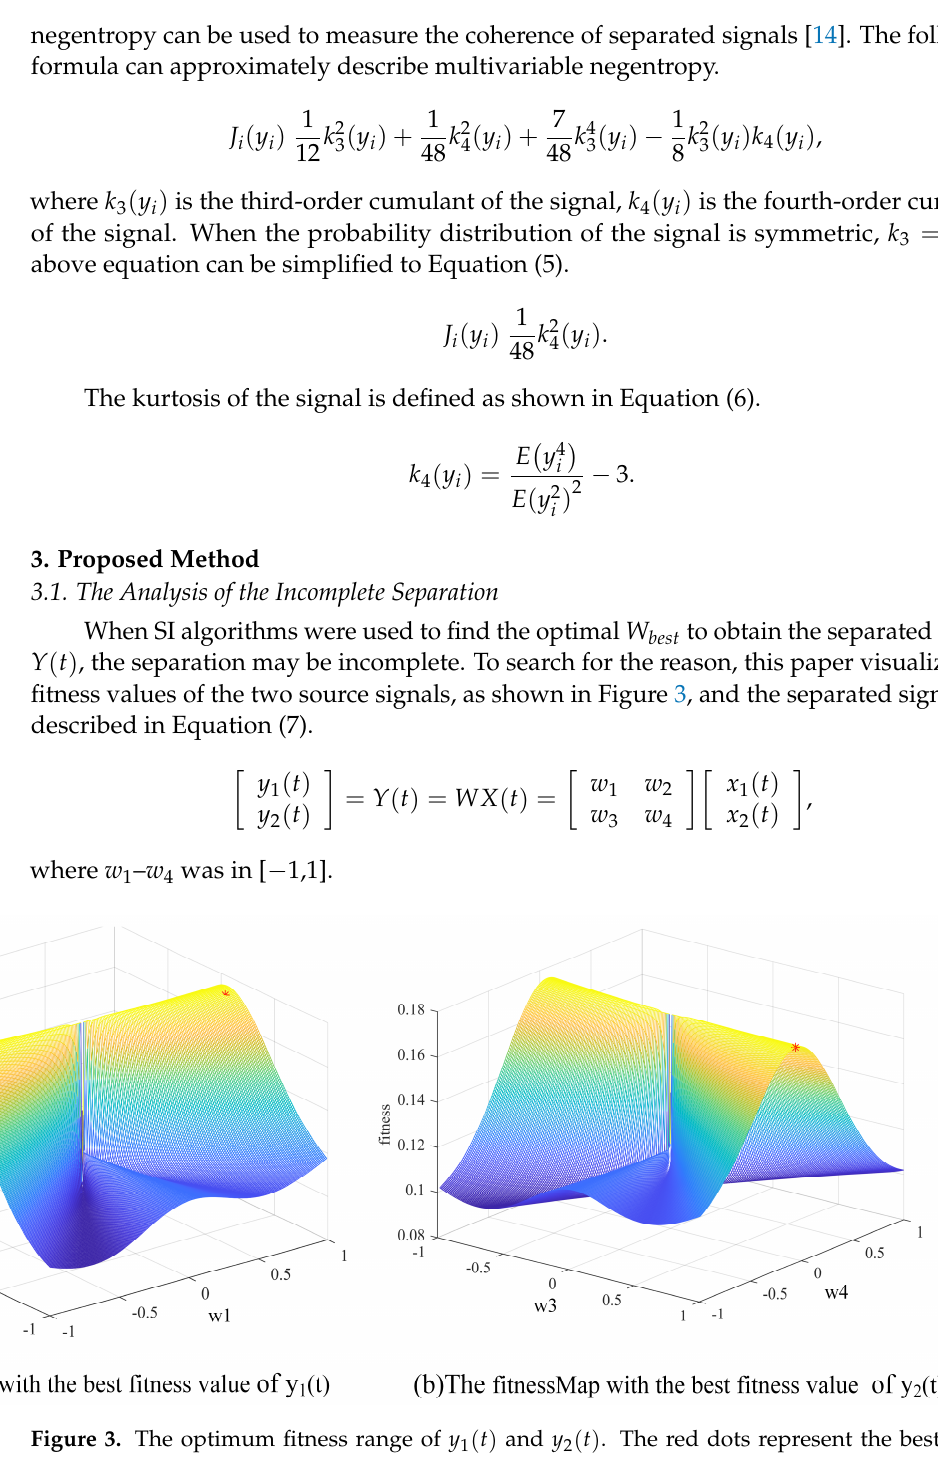
Figure 3. The optimum fitness range of (cid:1877) (cid:2869) (t) and (cid:1877) (cid:2870) (t) . The red dots represent the best fitness